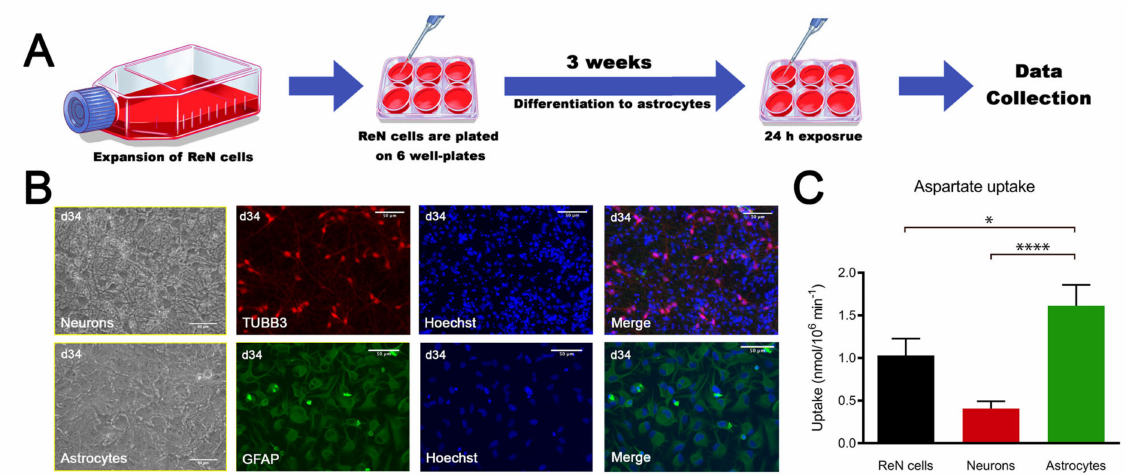
Figure 1. ReN cell-derived astrocytes are functional. ( A ) Scheme of the experiment. ( B ) Bright field pictures from neurons and astrocytes and immunostaining for TUBB3 (red) and glial fibrillary acidic protein (GFAP) (green); nuclei are stained with Hoechst (blue). ( C ) Aspartate uptake of ReN cells, neurons and astrocytes. Results are expressed as mean ± SD, n = 10 for ReN cells, n = 9 for neurons, n = 14 for astrocytes, obtained in 3 independent experiments. Kruskal–Wallis test was followed by Dunn’s multiple comparisons test. * p < 0.05, **** p <